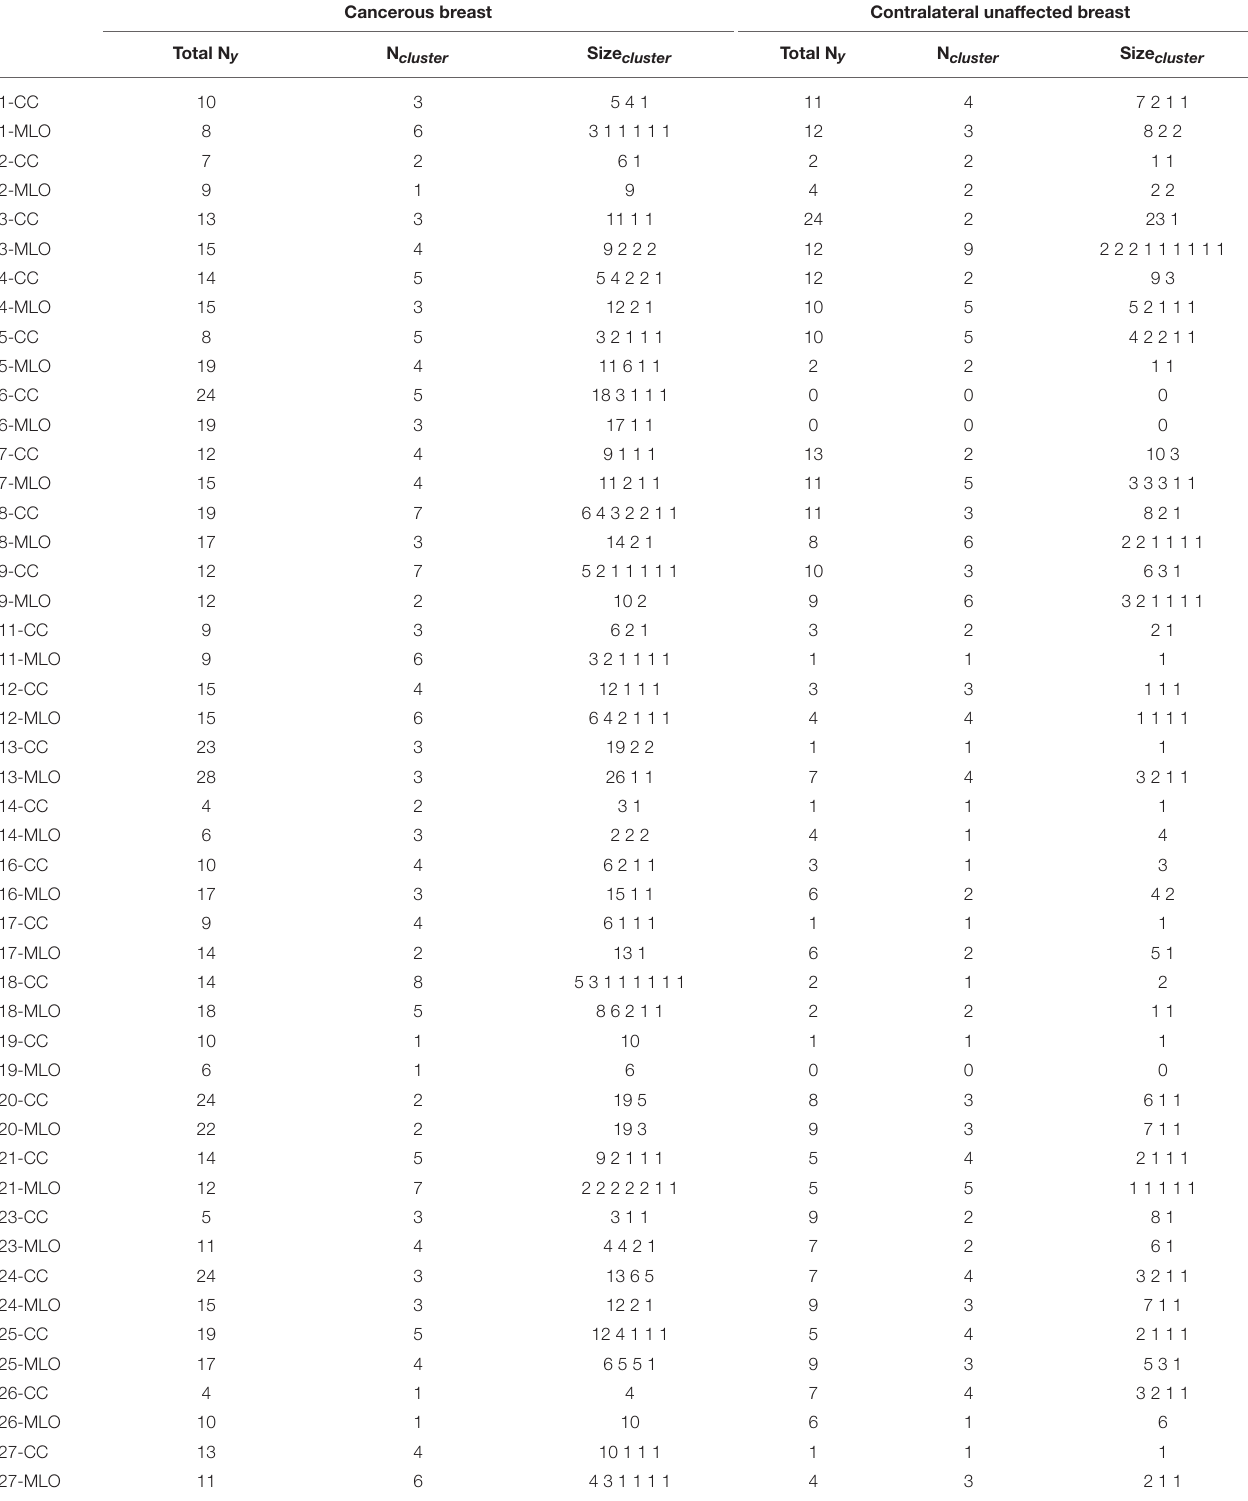
TABLE 1 | Statistics of monofractal uncorrelated H = 0.5 yellow square clusters in the CC and MLO mammographic views of the cancerous and contralateral unaffected breasts of our patients with breast cancer. Cancerous breast Contralateral unaffected breast Total N y N cluster Size cluster Total N y N cluster Size